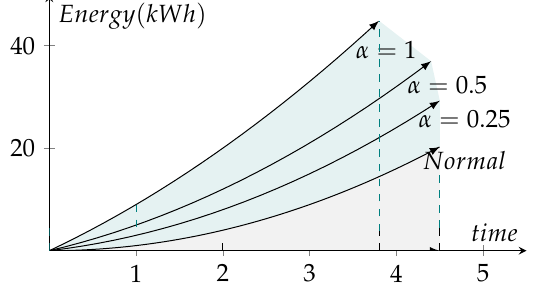
Figure 6. Impact of cryptojacking, showing energy consumption with cryptojacking at different